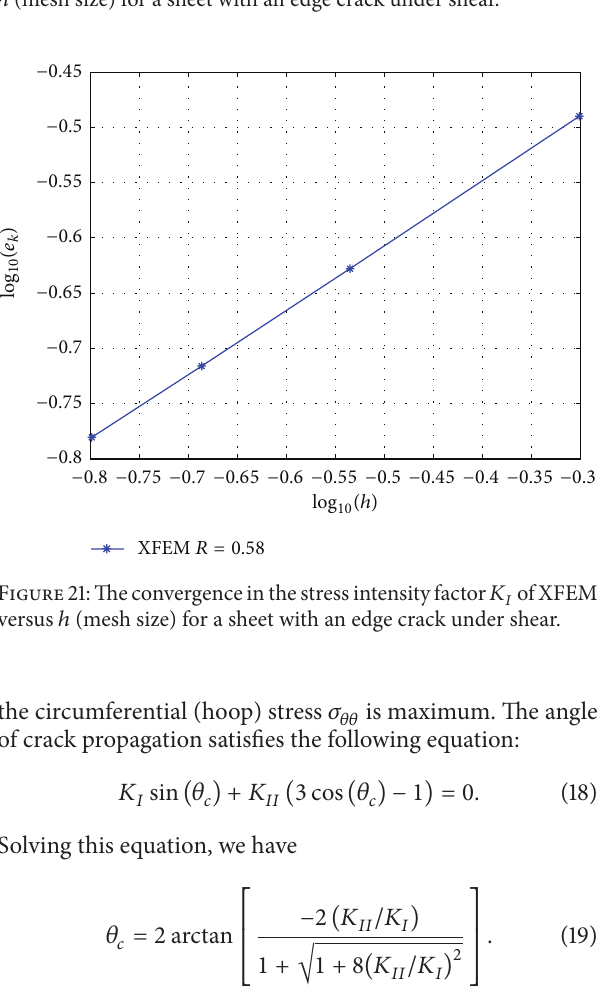
Figure 22: The convergence in the stress intensity factor 𝐾 𝐼𝐼 versus ℎ (mesh size) for sheet with edge crack under shear.